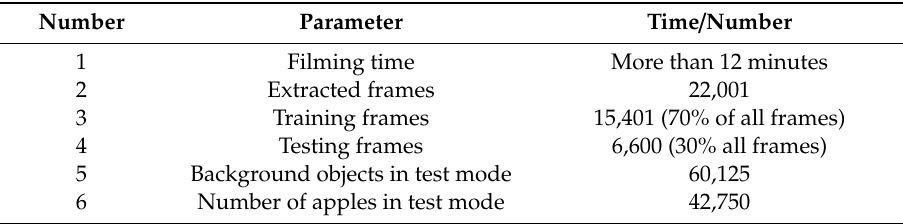
Table 1. Characteristics of video